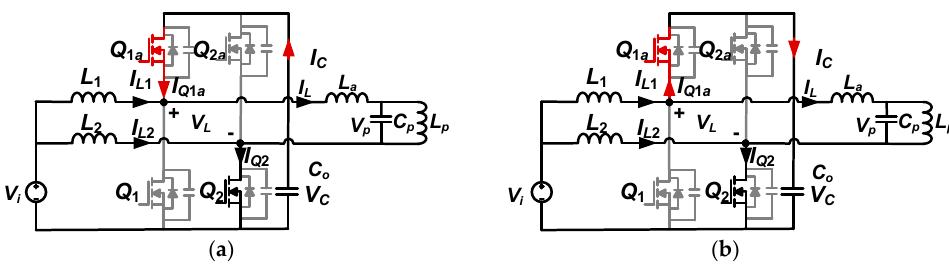
Figure 5. Current paths before turning OFF Q 1 a ( a ) preclude to the hard OFF; ( b ) preclude to the soft OFF.